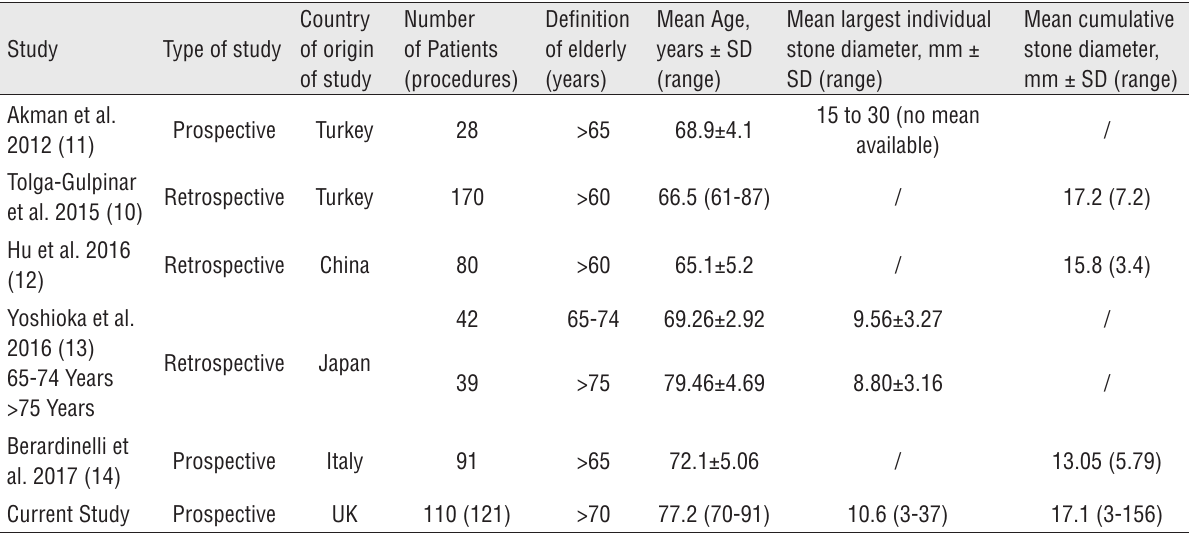
Table 3 - patient demographics across other studies reported in the